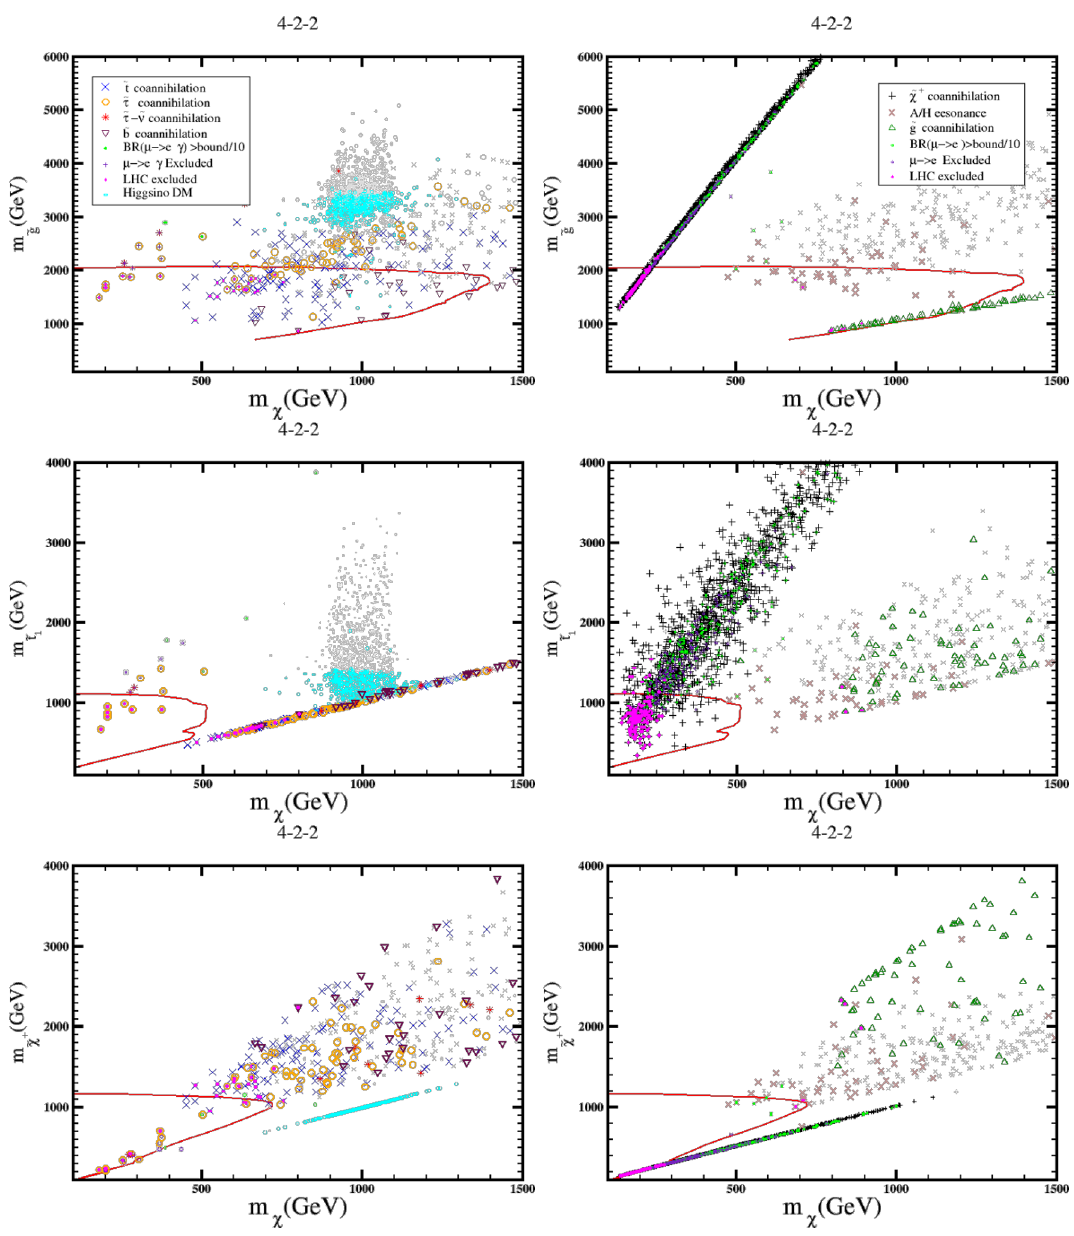
Figure 7 . LHC prospects for the 4-2-2 model, following the notations of (cid:12)gure 6. For clarity of presentation, in the left panels we display predictions for models with sfermion coannihilations, whereas in the right panels we display the remaining cases.